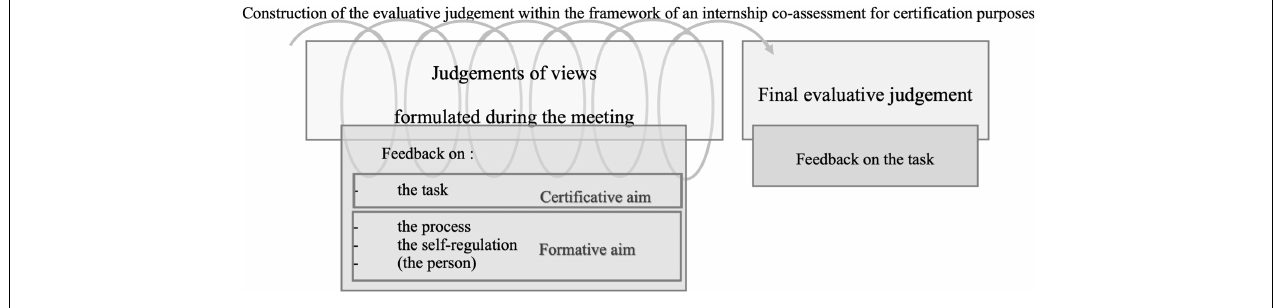
FIGURE 2 | Evaluative judgment construction (according to Hattie and Timperley, 2007; Mottier Lopez and Allal, 2008; Tourmen,